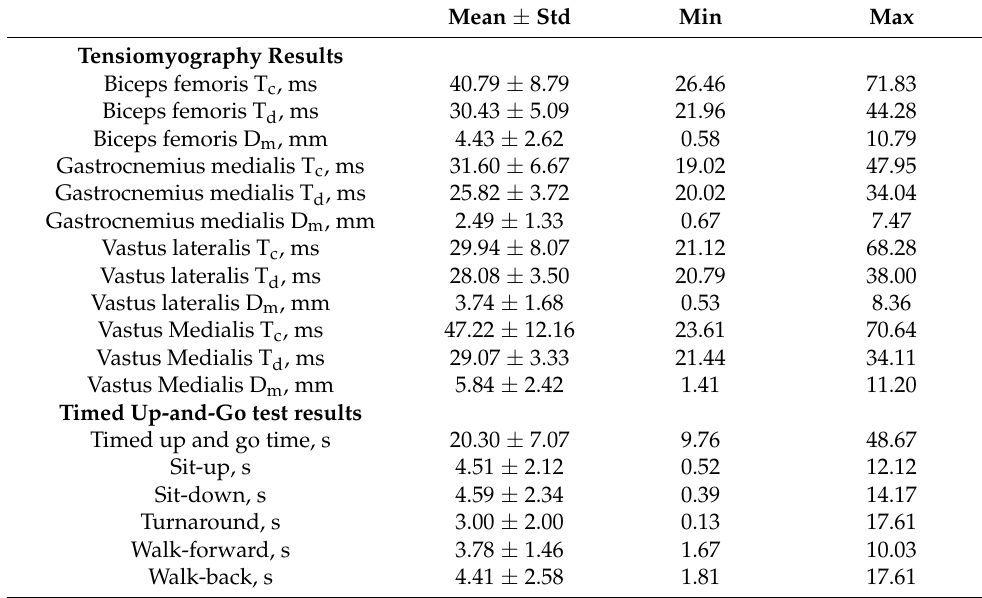
Table 2 shows the mean, minimal, and maximal values of all recorded TMG parameters and TUG test times. The correlation results between TUG test subtask and TMG parameters and the complete TUG test time are shown in Table 3. Table 2. Values of all recorded tensiomyography parameters and Timed Up-and-Go test times.